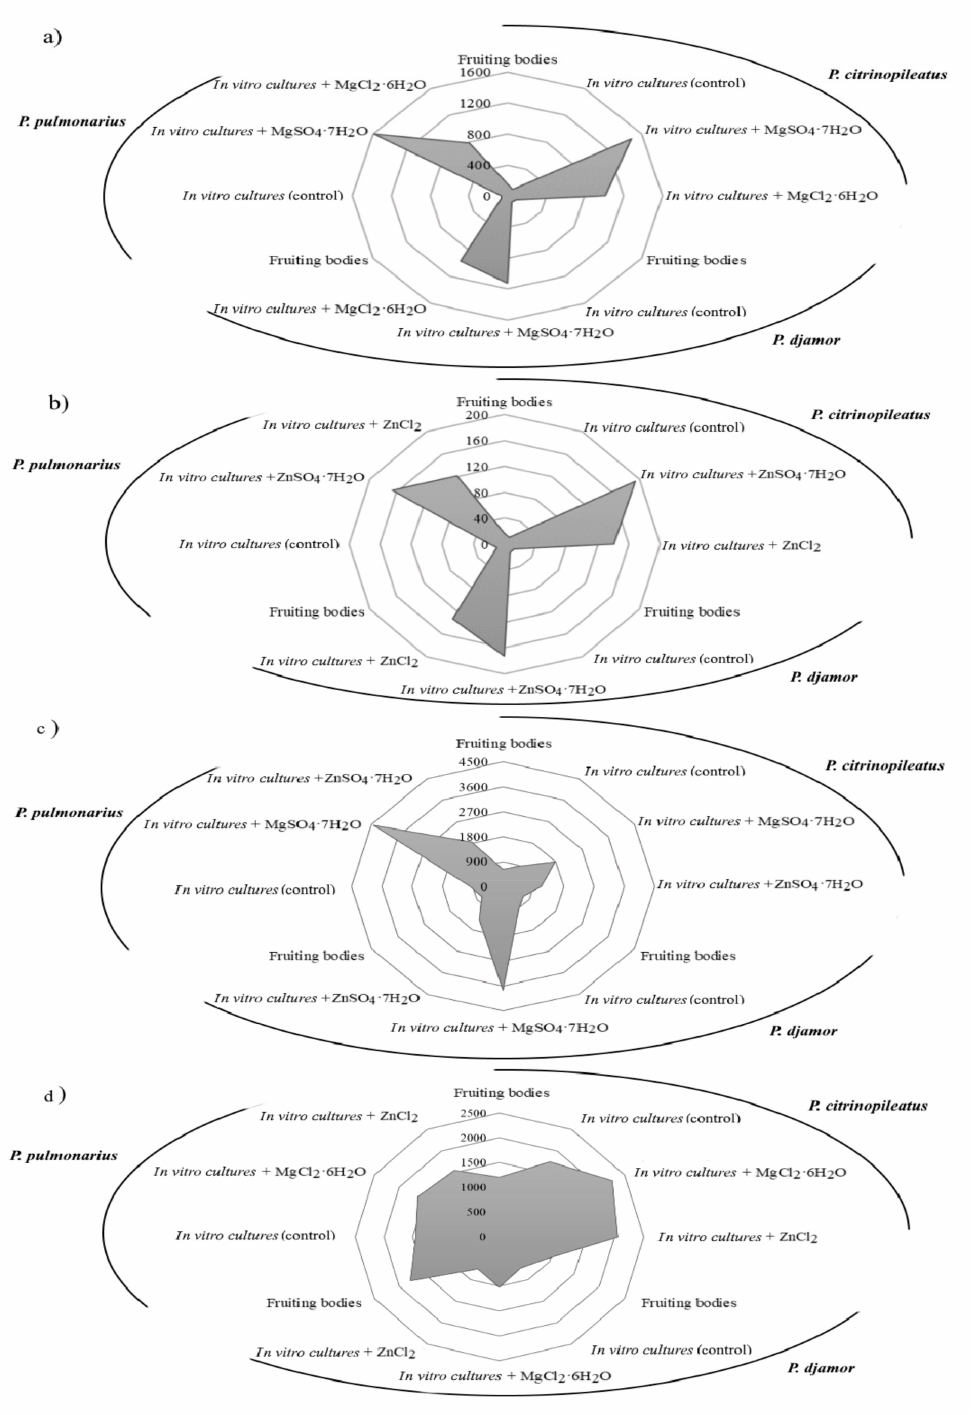
Figure 2. The concentration of ( a ) Mg and ( b ) Zn (mg/100 g d.w.) and the concentration of anions: ( c ) SO 42 − and ( d ) Cl − in the fruiting bodies of Pleurotus citrinopileatus , Pleurotus djamor , and Pleurotus Pulmonarius after in vitro cultivation in media enriched with zinc (ZnSO 4 · 7H 2 O and ZnCl 2 ) and magnesium salts (MgSO 4 · 7H 2 O and MgCl 2 · 6H 2